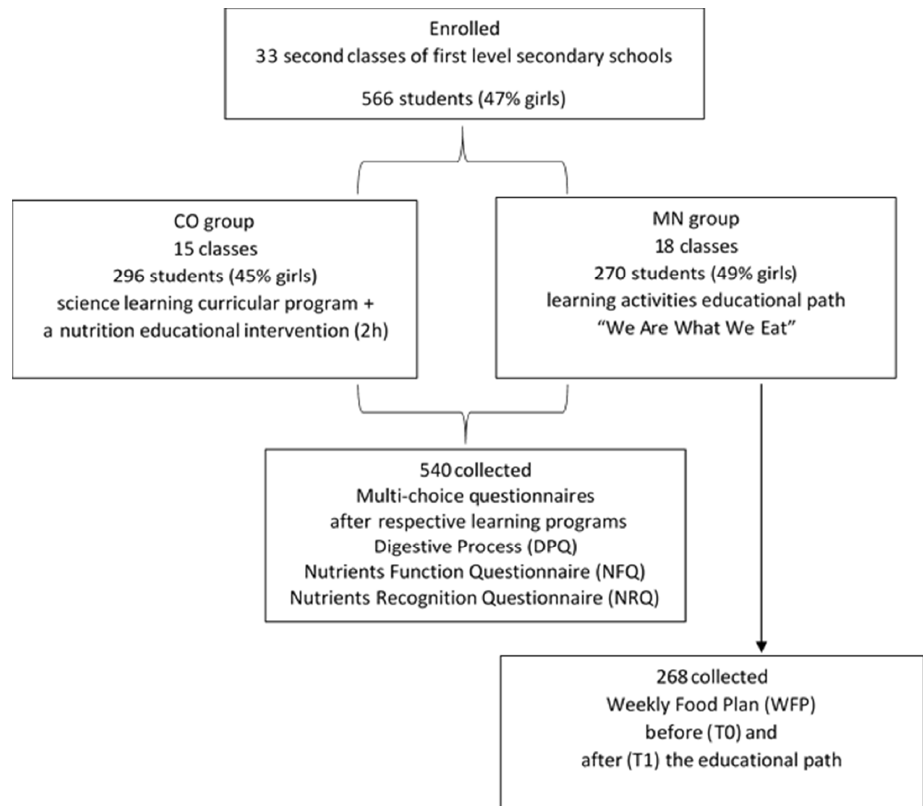
Figure 1. Flow chart of the study and subject recruitment.